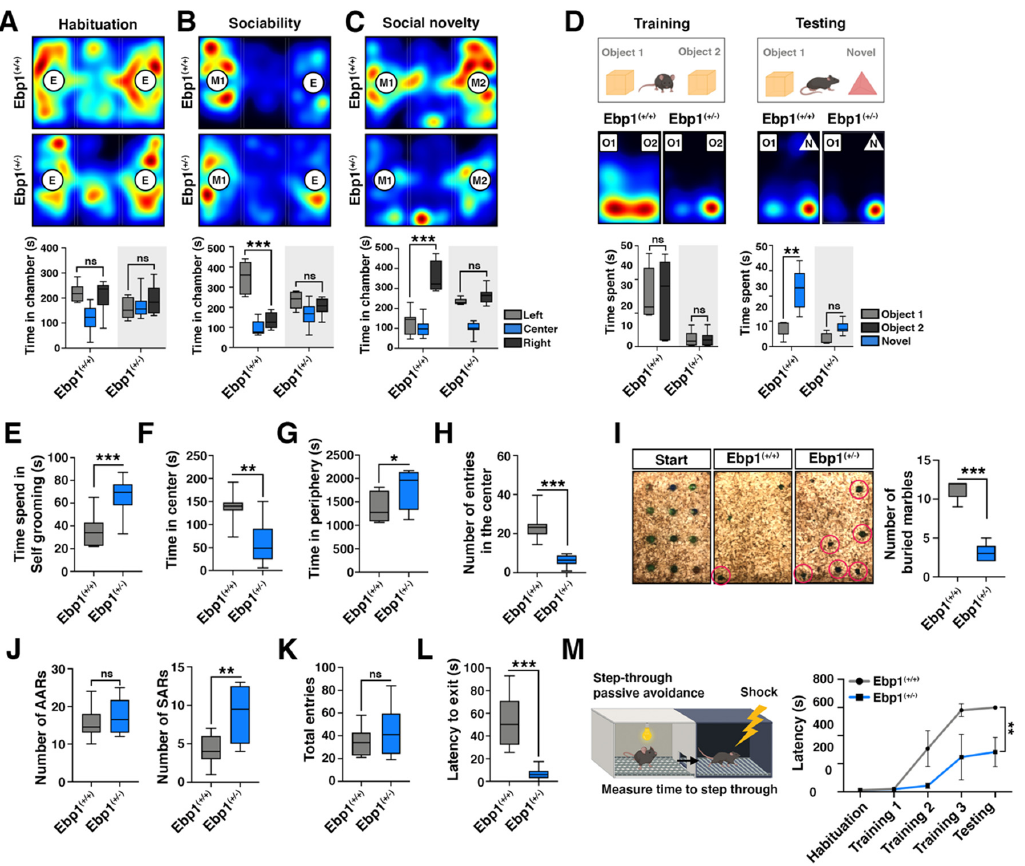
Figure 3. Ebp1 ( +/ − ) mice display SZ-like behaviors. ( A – C ) Representative heat maps illustrating the time spent in di ff erent locations of the three chambers from the social preference test. (upper). ( A ) In the first 10 min, the test mouse was placed in the center and allowed to explore each chamber as habituation liberally. * p < 0.05. ( B ) In the second 10 min, an age- and gender-matched WT B6 mouse (mouse 1) that had never been exposed to the test mouse, was placed in the wired cage of left chamber. The other side remained empty. The test mouse was placed in the center of the cage and allowed to explore the chamber for 10 min liberally. * p < 0.05. ( C ) In the last experiment, a new stranger mouse (mouse 2) was introduced in the wired cage of right chamber. The test mouse was allowed to explore the chamber for 10 min liberally. * p < 0.05. E, empty; M1, mouse 1; M2, mouse 2. Ebp1 ( +/+ ) , n = 12; Ebp1 ( +/+ ) , n = 12. ( D ) Representative scheme and heat maps illustrating the time spent in di ff erent locations of novel object recognition test (upper). The test mouse was placed in the middle of objects and allowed to explore the cage and measured explore time with two objects for 10 min (bottom, left). Next day, one of the objects was replaced with a novel object and measured explore time with object1 and novel object for 10 min. ** p < 0.01. O1, object 1; O2, object 2; N, novel object. Ebp1 ( +/+ ) , n = 12; Ebp1 ( +/+ ) , n = 12. ( E ) Self-grooming assessed as repetitive grooming was scored during 10 min manually. * p < 0.05. Ebp1 (+/+) , n = 12; Ebp1 (+/+) , n = 12. (F,G) Open field test; the area was separated into two zones and included the center (28.5 × 28.5 cm) and the periphery (around of center zone) areas. * p < 0.05. (H) The number of entries in the center zone was counted. Open field test was performed for 192 20 min. Ebp1 (+/+) , n = 12; Ebp1 (+/+) , n = 12. (I) Marble-burying test; WT ( n = 12) and mutant mice ( n = 12) 193 were placed in the cage for 30 min and allowed to roam liberally. The over 2/3 buried marbles were 194 counted. * p < 0.05. ( J–L ) Y-maze experimental data; ( J ) Visiting of arms in the order 1–2-3 is an 195 example of an alternation (left, AAR), whereas the order of 1–2-1 was considered as the non- 196 alternation (right, SAR). ( K ) Total entry number and (L) latency to exit were counted. AAR, 197 alternation arm returns; SAR, same arm returns. Ebp1 (+/+) , n = 12; Ebp1 (+/+) , n = 12. ( M ) Passive 198 avoidance test; WT ( n = 12) and Ebp1 mutant mice ( n = 12) were tested and the duration of the freezing 199